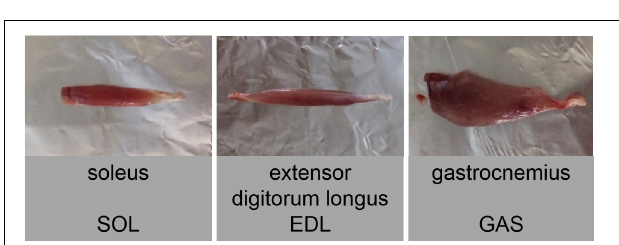
FIGURE 2 | Images of skeletal muscles of Daurian ground